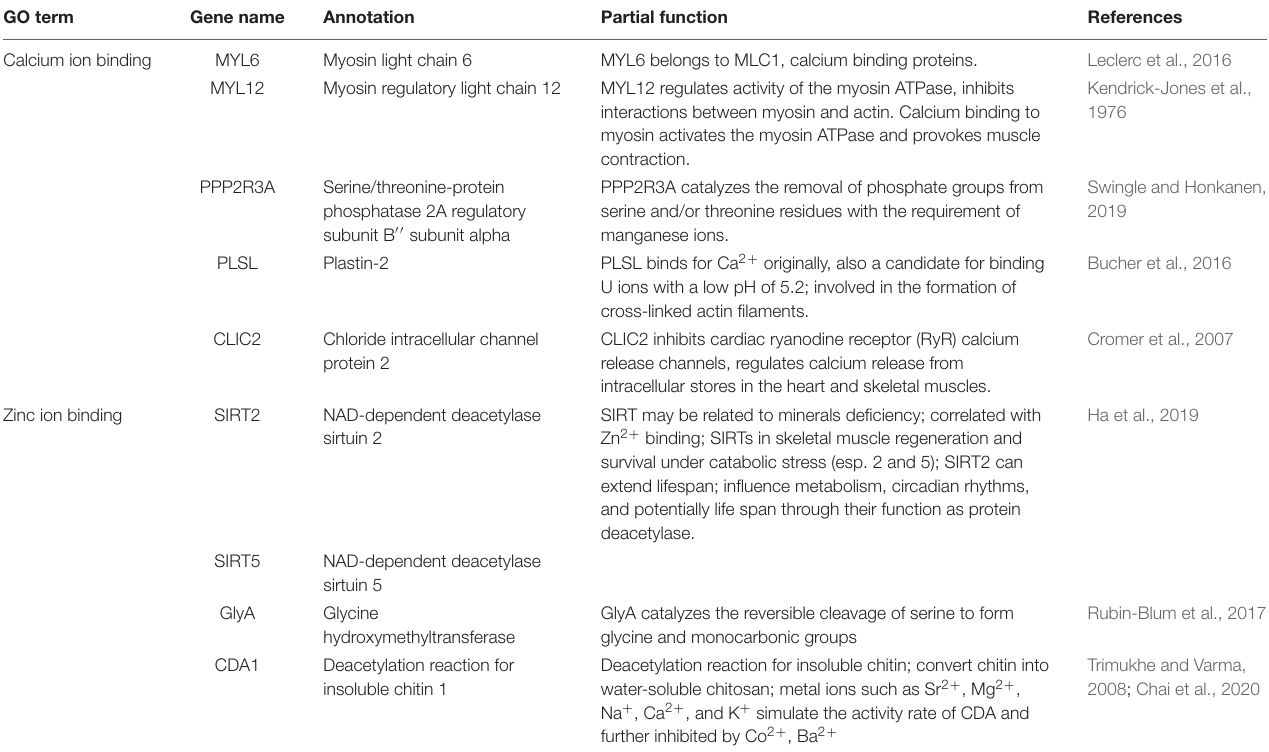
TABLE 3 | Nine enriched outlier-associated unigenes related with metal ion binding.